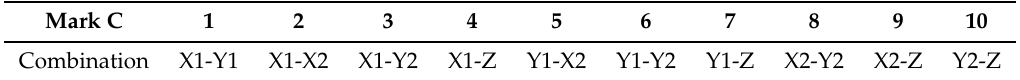
Table 3. The relationship between C and feature combinations.